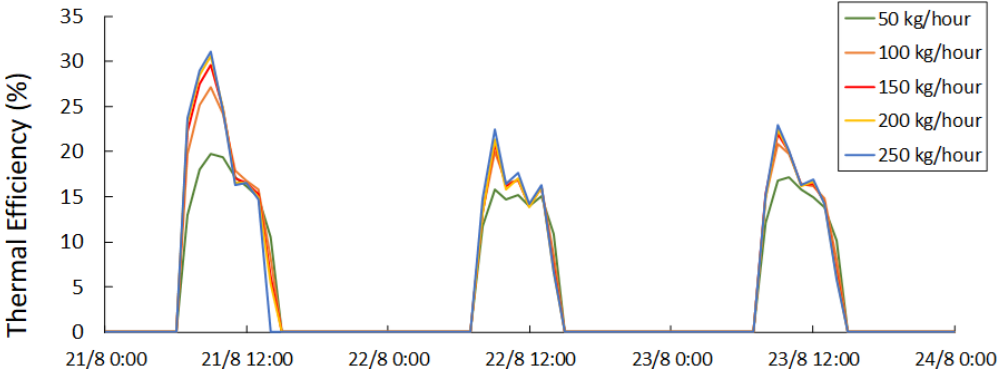
Figure 6. Thermal efficiency variations with various operating fluid flow rates.